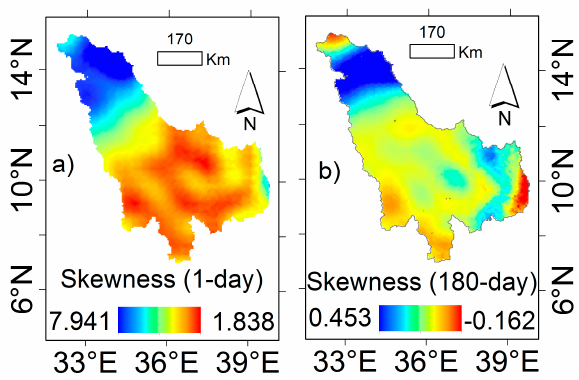
Figure 10. Meteorological dry and wet conditions in terms of: ( a , c ) SPEI; and ( b , d ) NPI applied to catchment-wide daily precipitation insufficiency. The label text in “( )” of the legend shows the aggregation level.